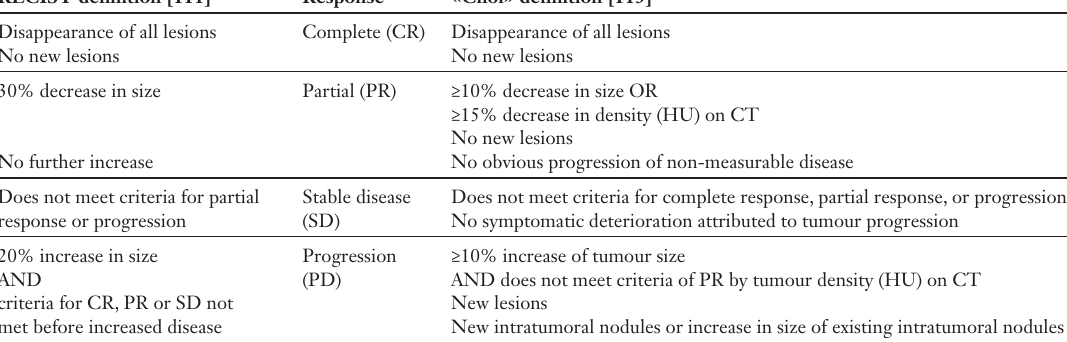
RECIST and modified CT response evalua- tion criteria [111,